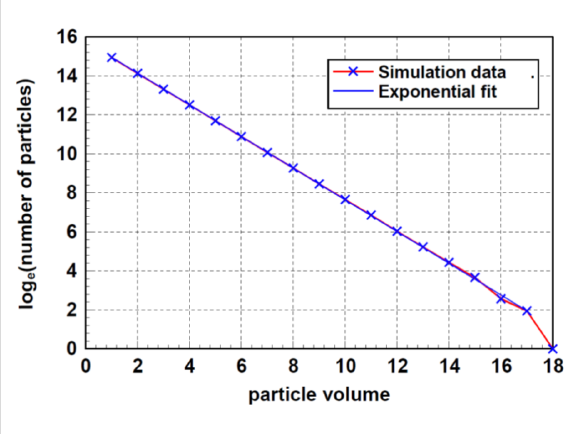
Figure 2: Plot of the distribution function after 4.7 × 10 6 collisions of a starting ensemble consisting of 10 7 particles, the ordinate is trans- formed to the natural logarithm, log e ( N i ) = log e ( a ) − bi . Additionally, the fit of this distribution with an exponential function is depicted. One real- izes a perfect fit for statistically significant numbers of particles.